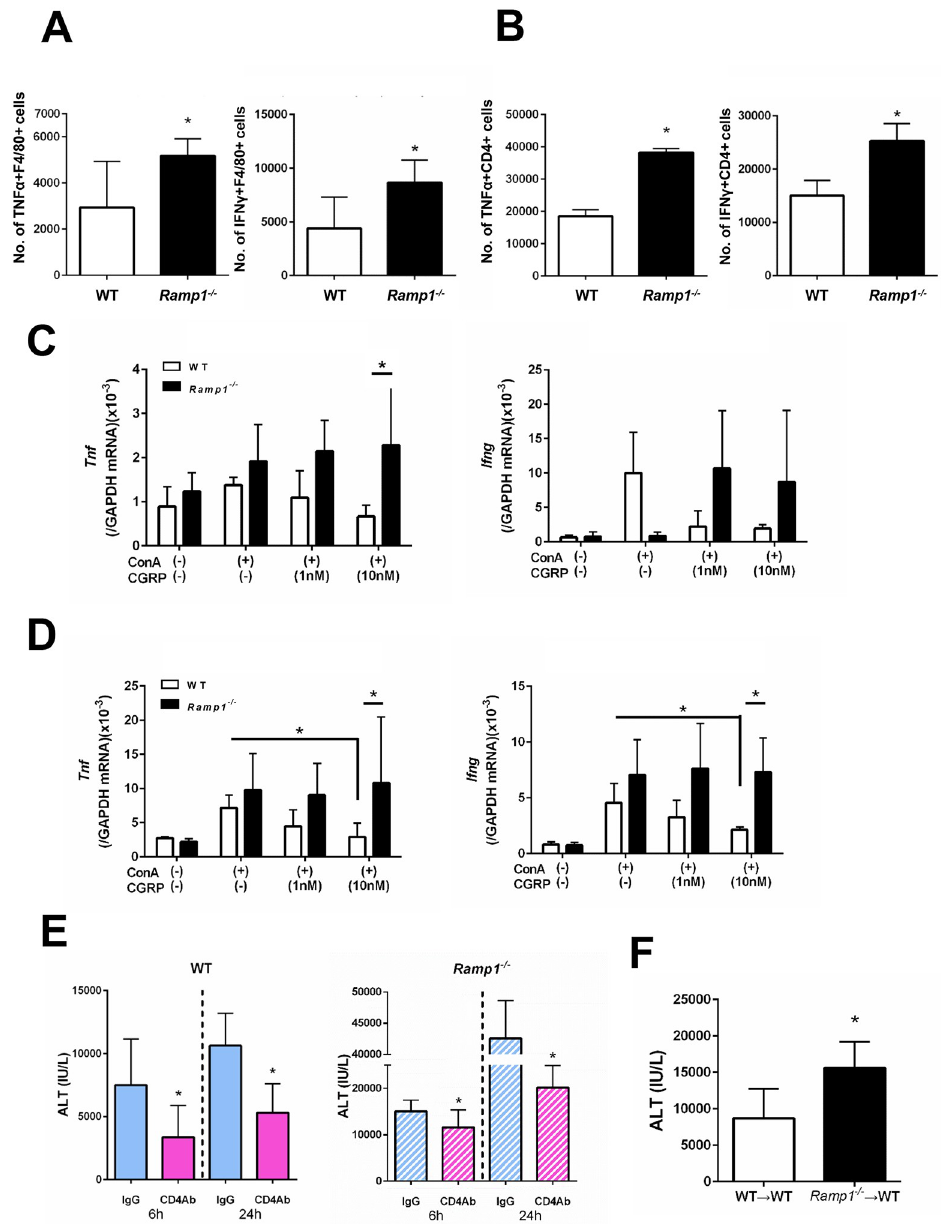
Fig 4. RAMP1 signaling regulates expression of pro-inflammatory cytokines by splenic macrophages and T cells. (A,B) The numbers of TNF α - and IFN γ -expressing cells within splenic F4/80+ cells (A) and splenic CD4+ T cells (B) populations from WT and Ramp1 -/- mice at 1 h after ConA treatment. Expression of TNF α and IFN γ was analyzed by flow cytometry. Data are expressed as the mean ± SD from six mice per group. � p < 0.05 vs . WT mice. (C) Amounts of Tnf and Ifng mRNA expressed by splenic F4/80+ cells isolated from WT and Ramp1 -/- mice. Isolated splenic macrophages were stimulated with CGRP (1 and 10 nM) with or without ConA for 3 h. Macrophages were isolated by magnetic-activated cell sorting (MACS). Data are expressed as the mean ± SD from 4–5 mice per group. � p < 0.05. (D) Expression of Tnf and Ifng mRNA by splenic CD4+ T cells isolated from WT and Ramp1 -/- mice. Isolated splenic CD4 + T cells were stimulated with CGRP with or without ConA for 1 h. CD4+ T cells were isolated by magnetic-activated cell sorting (MACS). Data are expressed as the mean ± SD from 4–5 mice per group. � p < 0.05. (E) Serum ALT levels after deletion of CD4+ T cells from WT and Ramp1 -/- mice during ConA hepatitis. Anti-CD4 antibodies or isotype IgG was administered 24 h before ConA treatment. Data are expressed as the mean ± SD from 3–6 mice per group. � p < 0.05 vs . IgG-treated mice. (F) Adoptive transfer of CD4+ T cells from Ramp1 -/- mice into WT mice ( Ramp1 -/- ! WT). Data are expressed as the mean ± SD from 3–6 mice per group. � p < 0.05 vs . WT ! WT.